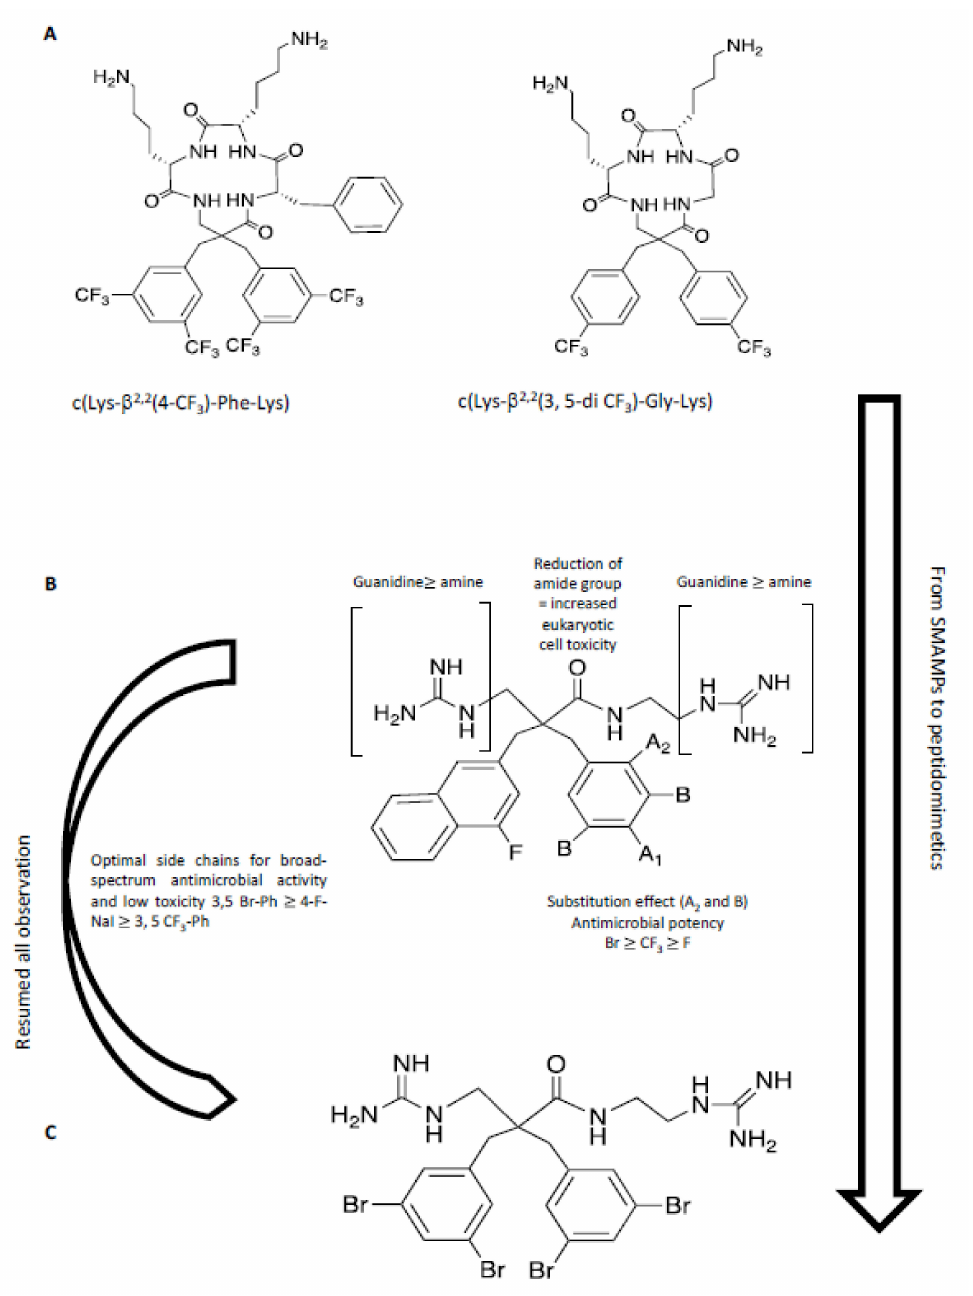
Figure 8. In this figure, a hierarchical approach from peptide to peptidomimetic is resumed. ( A ) From SMAMPs [219]: a peptide scaffold was used to investigate the effect of halogenation and hydropho- bicity. ( B ) Summary of SAR for peptidomimetics [220]. ( C ) The optimized molecule with high antimicrobial activity and low toxicity in preliminary test in vitro and in vivo